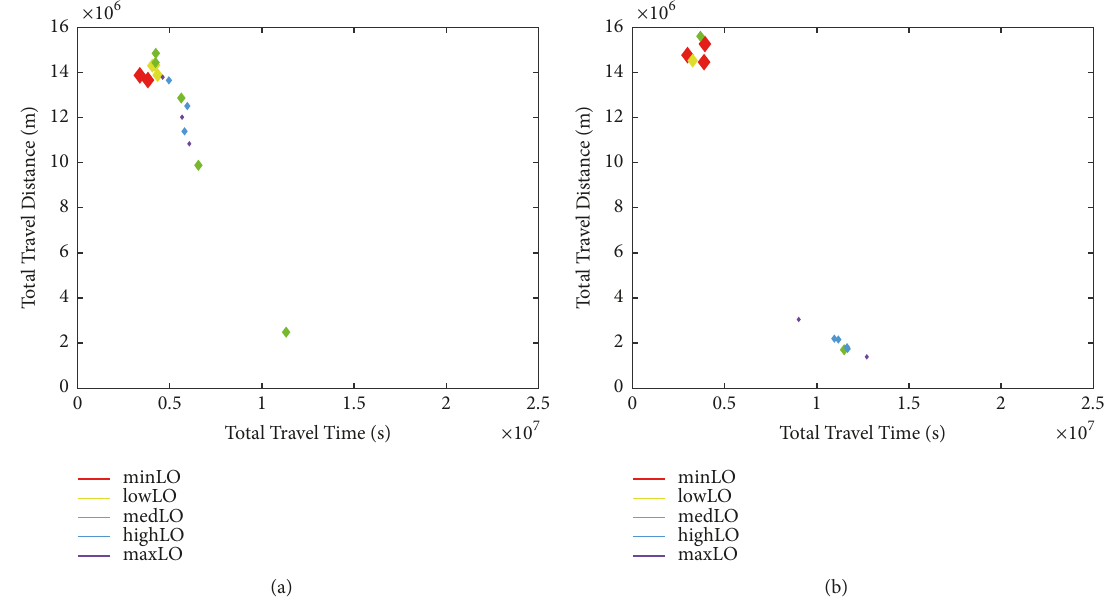
Figure 7: Final network states with demand level 4: examples of correlation with min local overlapping. (a) Case of “To Center” pattern and (b) case of “Uniform”